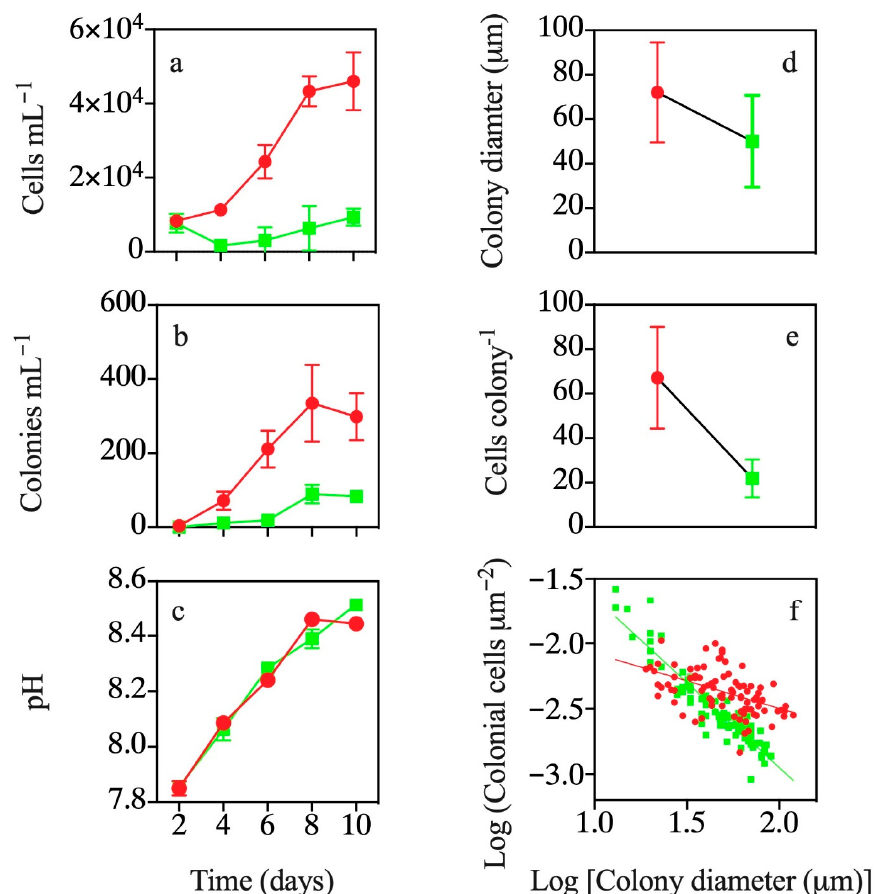
Figure 3. ( a ) The solitary cell abundances (Mean ± SD, n = 3), ( b ) the number of colonies (Mean ± SD, n = 3), ( c ) pH (Mean ± SD, n = 3), ( d ) colony diameters (Mean ± SD, n = 90), ( e ) the number of cells per colony (Mean ± SD, n = 90) and ( f ) linear relationship between Log (colonial cells µm − 2 ) and Log [colony diameter (µm)] (n = 90 for control and treatment) in P. globosa grown alone (red circles) and exposed to T. weissflogii extracellular exudates diffused through a 2-µm filter (green